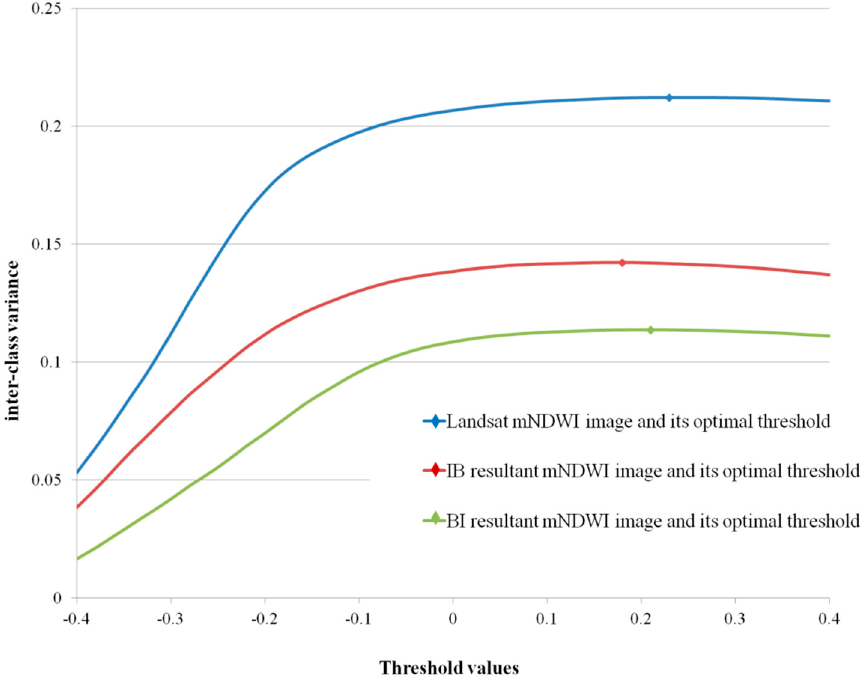
Figure 5. Intra-class variances of different threshold values on three mNDWI images, along with their optimal thresholds.